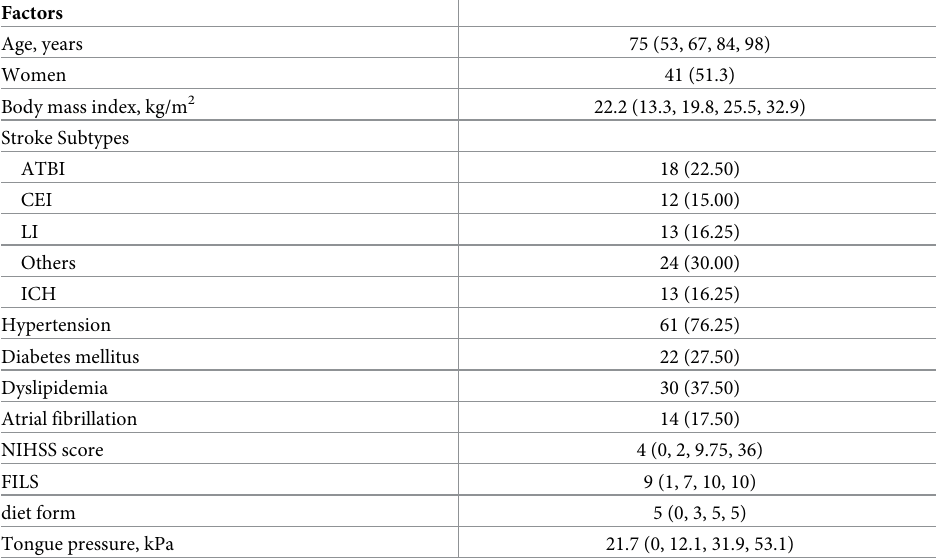
Table 1. Patient characteristics (n =